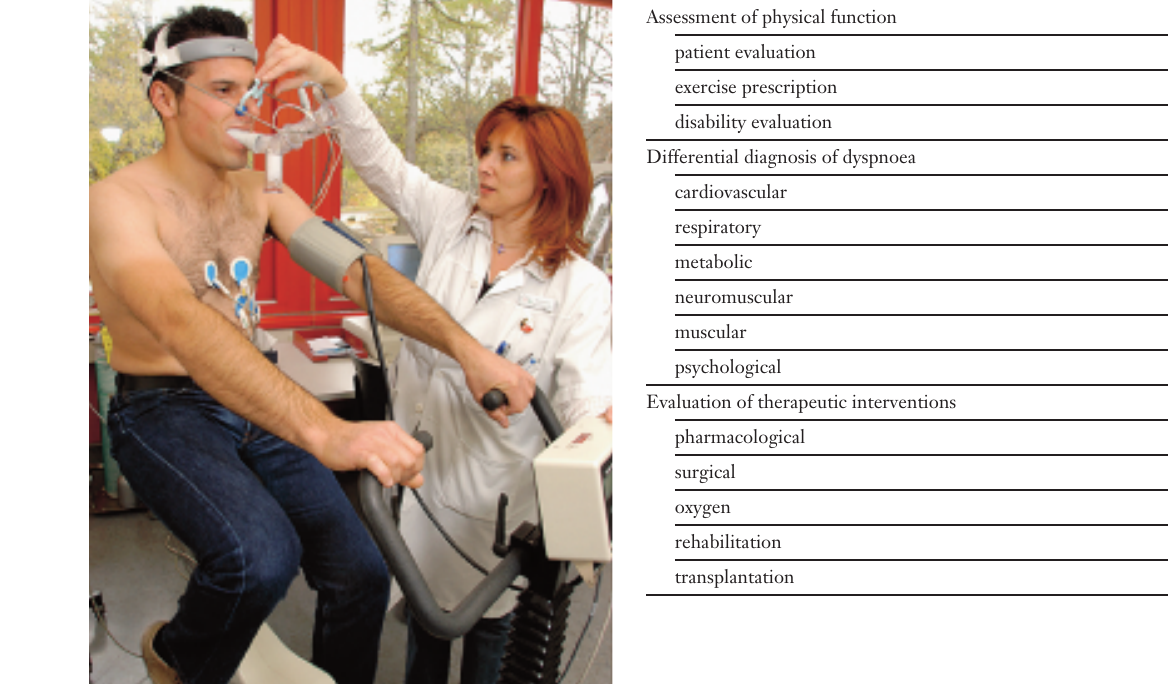
Indications for exercise testing in respiratory diseases. Cardiopulmonary exercice testing requires sophisticated